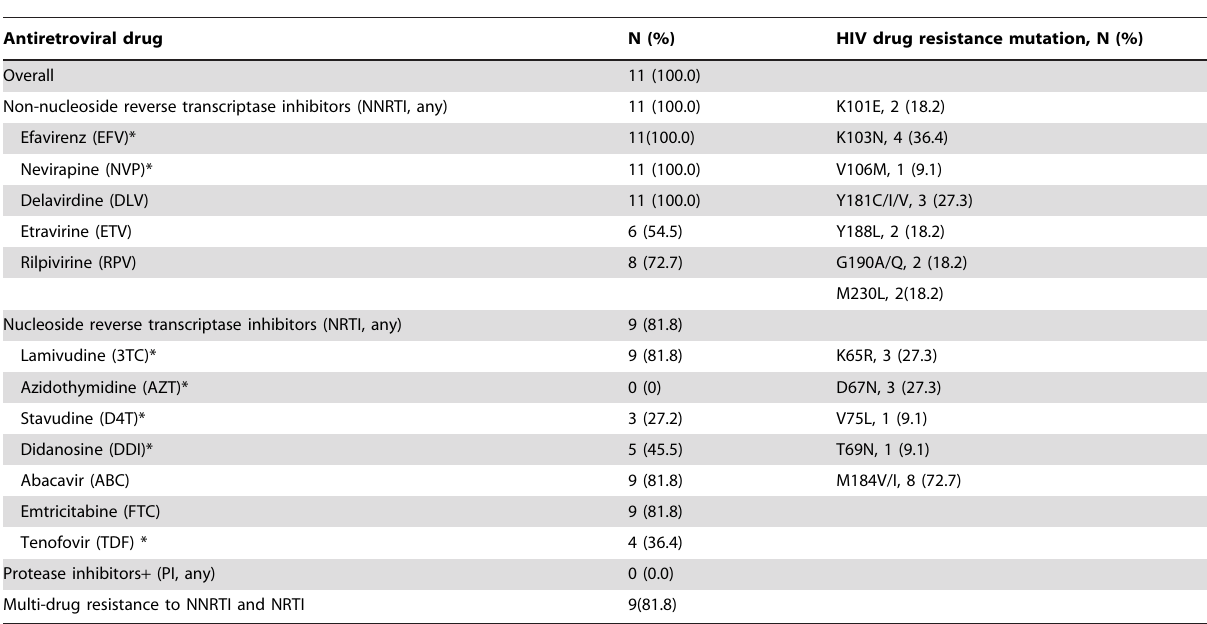
Table 2. HIV drug resistance and drug resistance mutations among the 11 patients with HIVDR mutations detected at 12 months at four sentinel antiretroviral treatment